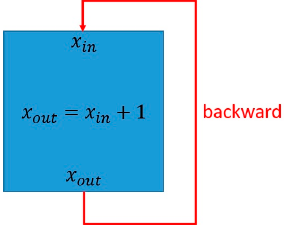
Figure 8. Example of a component computing 𝑥 = 𝑥 + 1 .